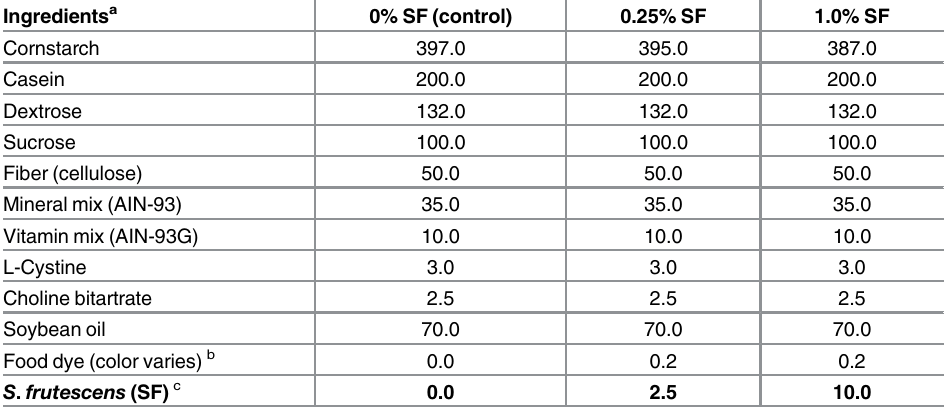
Table 1. Composition of Experimental Diets Containing 0, 0.25 or 1.0% S . frutescens (SF) for Mouse Feeding Experiments (g/kg). Ingredients